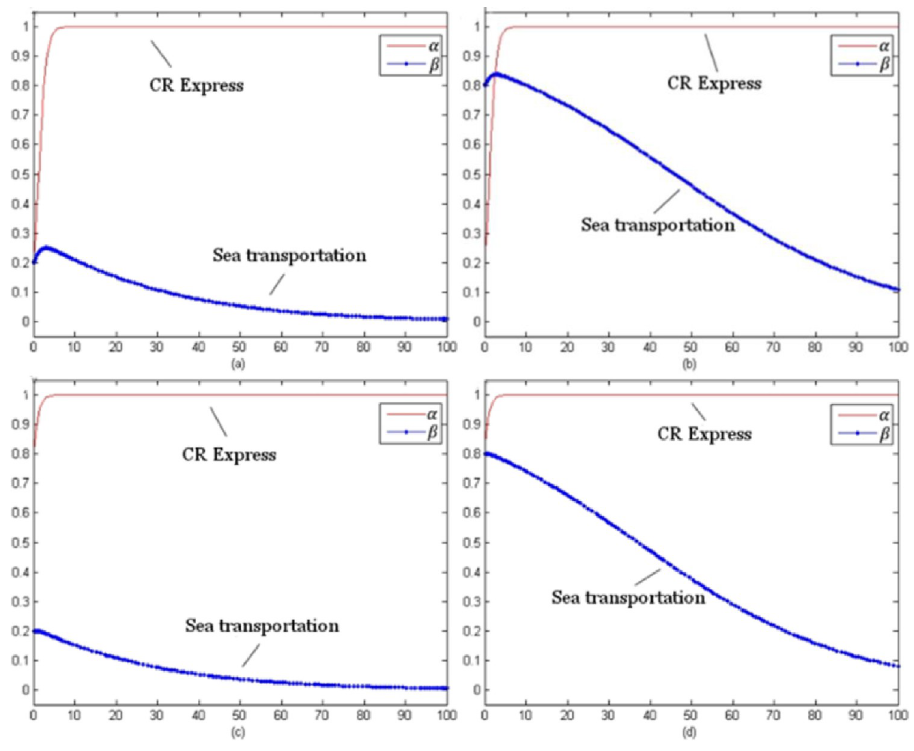
Fig 5. Game evolution trend of fruit transportation competition (with